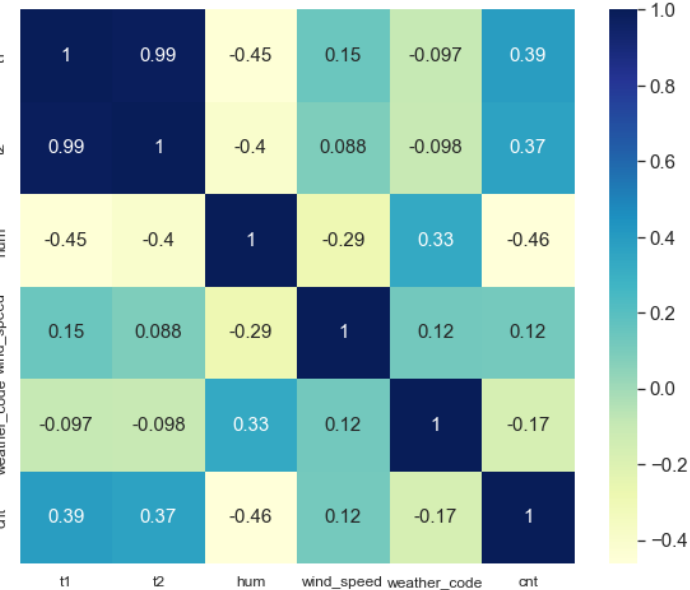
Figure 5. Correlation analysis figure between meteorological factors and demand for shared